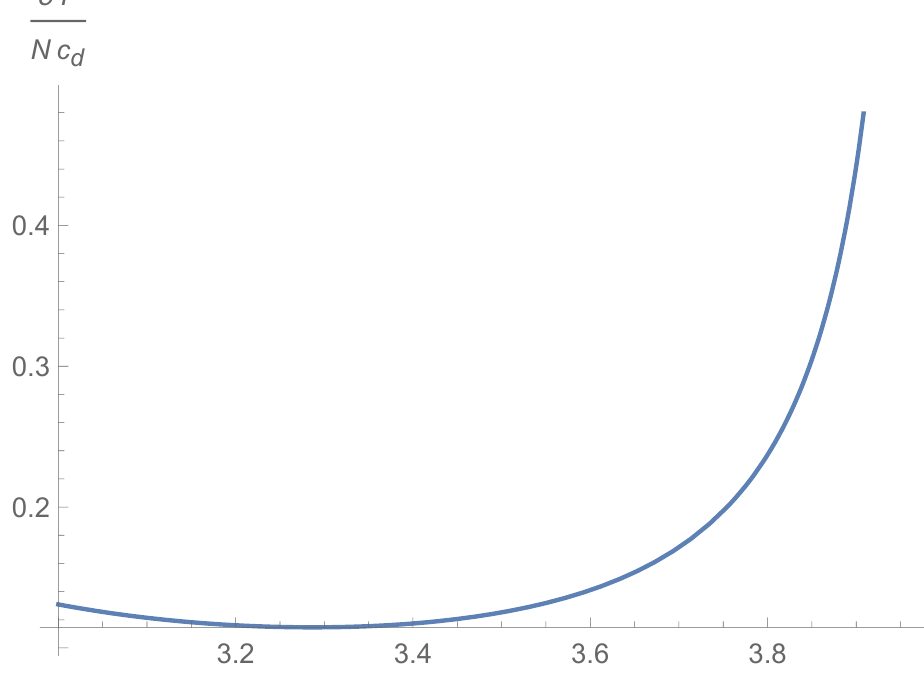
− ˜ F σ ∗ =2 − d/ 2 σ ∗ = d/ 2 − 1